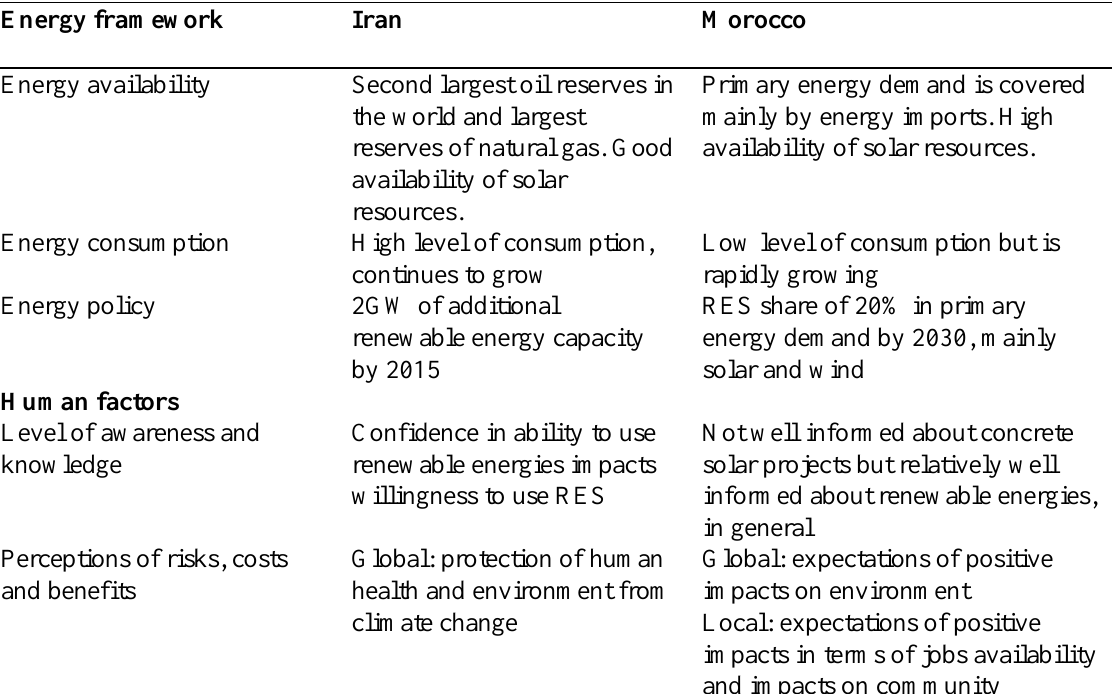
Table 1. Energy framework and human factors addressing deployment of renewable energy projects Energy framework